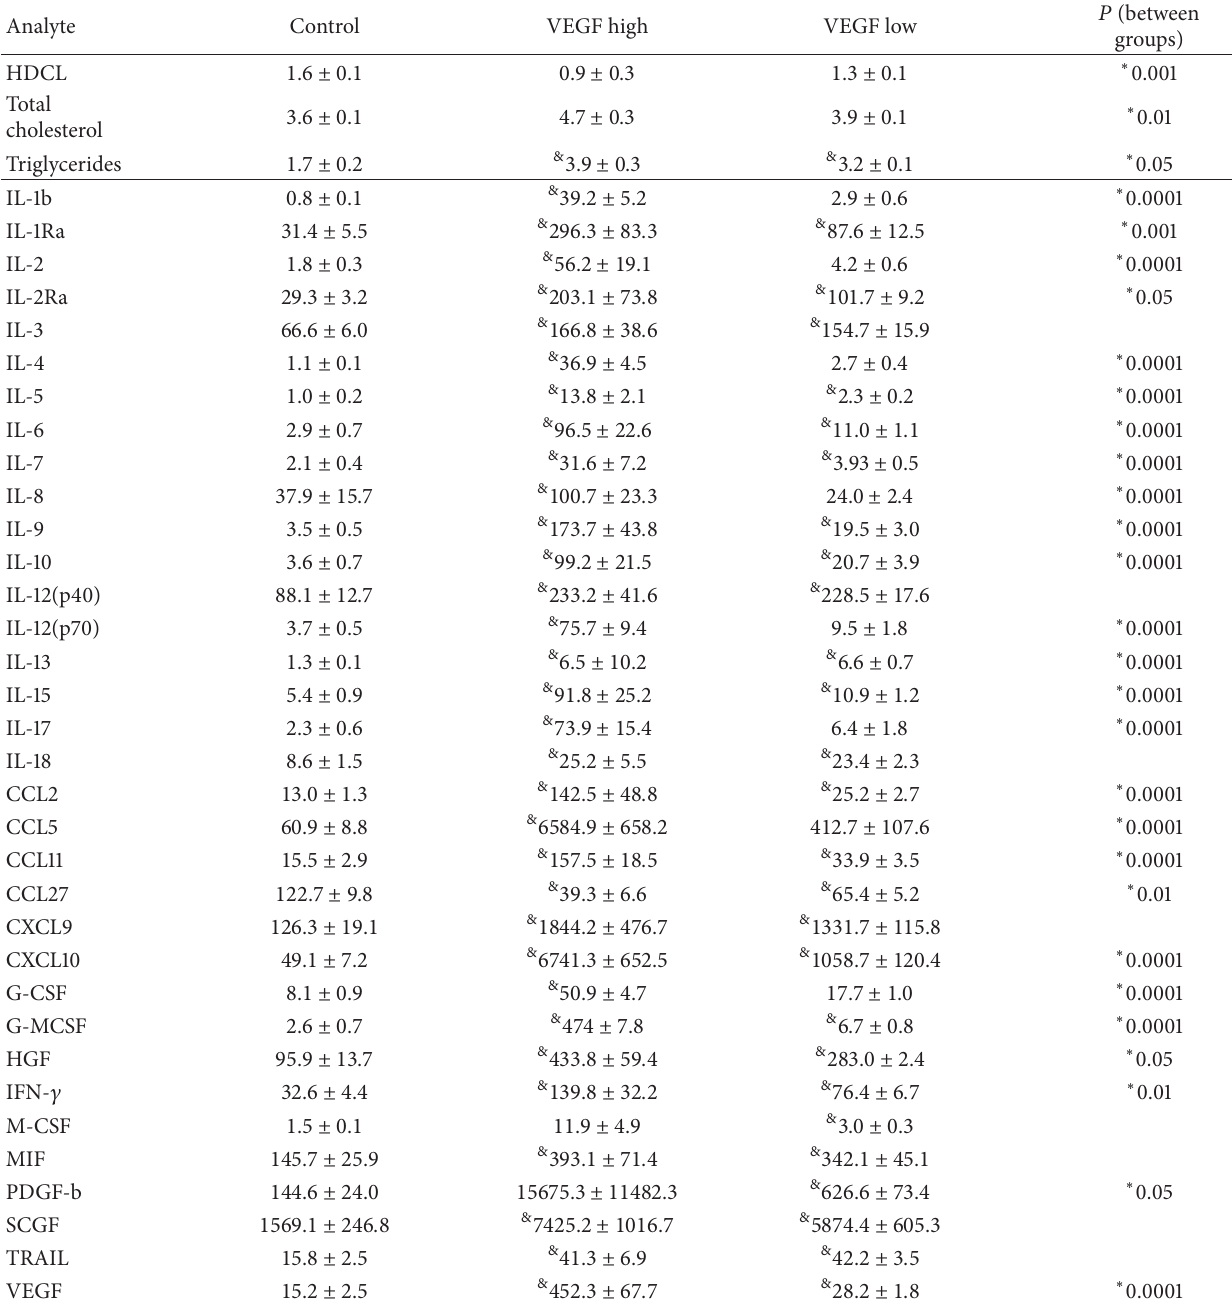
Table 9: Lipids (mmol/L) and cytokine (pg/mL) analysis based on high ( > 93 pg/mL) or low ( < 93 pg/mL) serum VEGF level. Analyte Control VEGF high VEGF low